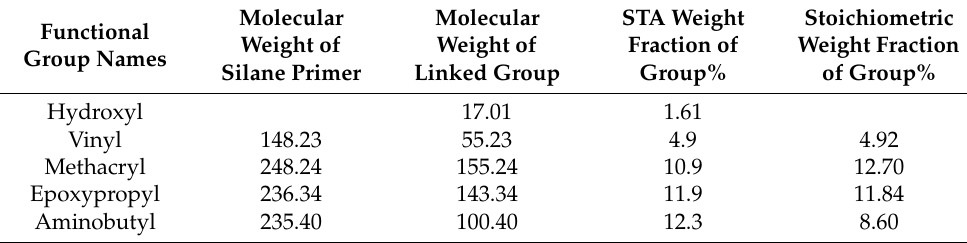
Table 2. Comparison of the functional groups’ stoichiometric amount with that obtained in the samples.